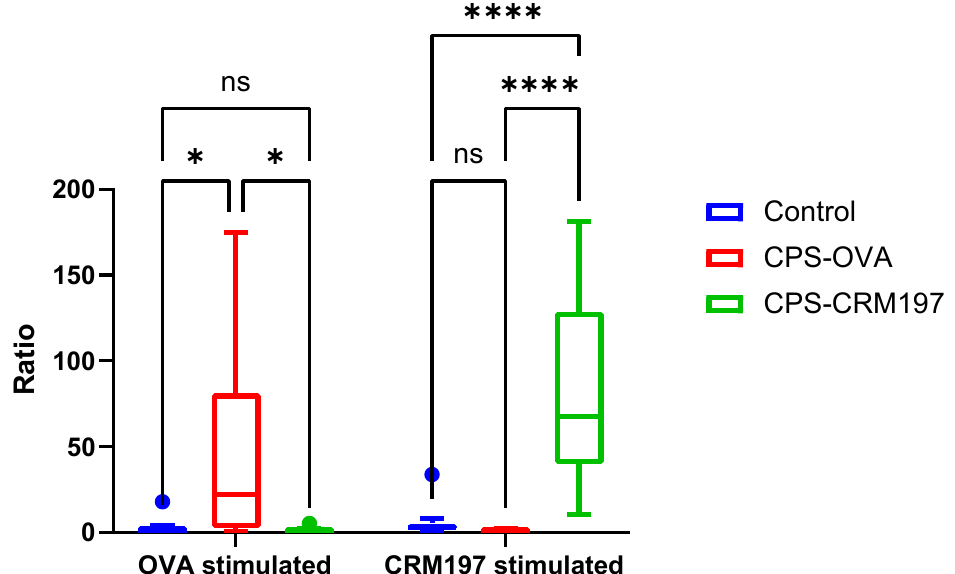
Figure 7. Cellular immune response to OVA or CRM197 in vitro re ‐ stimulation. Flow cytometry. Isolated PBMCs were re ‐ stimulated in vitro with OVA or CRM197 and subsequently stained for surface markers (CD3, CD4) and intracellular IFN γ . The ratio of IFN γ producing cells was analyzed from all CD3+CD4+ cells. The data are expressed as the ratio calculated: the percentage of CD4+IFN γ + from OVA (or CRM197) ‐ stimulated sample/percentage of CD4+IFN γ + from the un ‐ stimulated sample. Data are presented for individual animals from control, CPS ‐ OVA ‐ and CPS ‐ CRM197 ‐ immunized pigs. In comparison to the control and CPS ‐ CRM197 ‐ vaccinated groups, there was a significant response in the CPS ‐ OVA group when cells were re ‐ stimulated with OVA (*, p ≤ 0.05). Similarly, the CPS ‐ CRM197 ‐ vaccinated group showed an extremely significant response when compared to the control or CPS ‐ OVA ‐ vaccinated groups (****, p ≤ 0.0001).